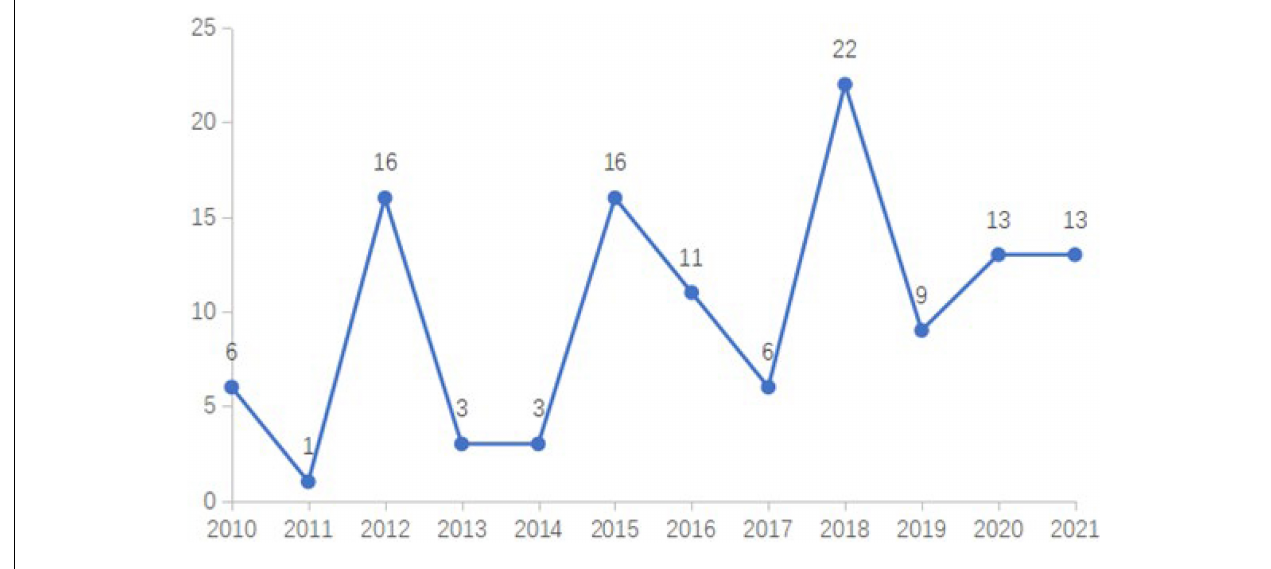
FIGURE 1 | Annual publishing: 2010–2021.